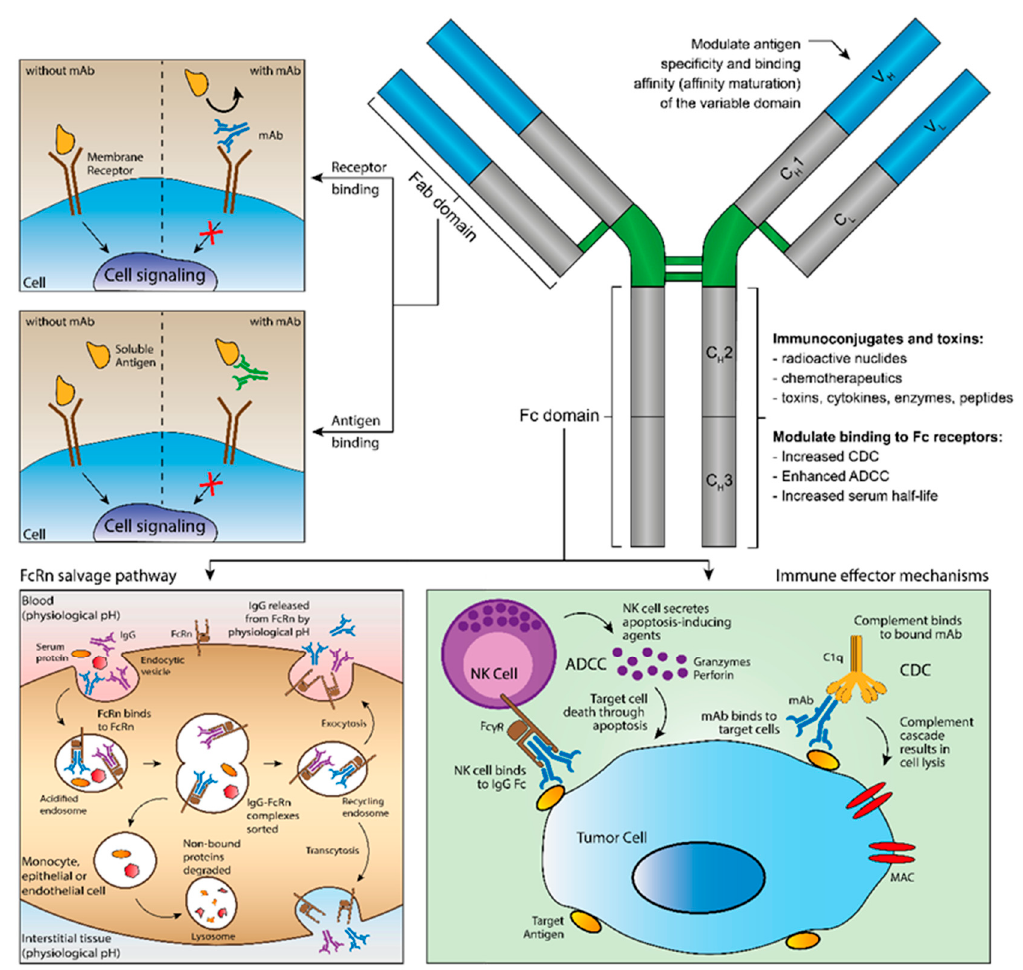
Figure 3. Main functions of therapeutic monoclonal antibodies (mAbs). mAbs have two antigen-binding fragments (Fabs) and one constant fragment crystallizable (Fc). The variable domain of the Fab confers specificity and binding affinity to either membrane receptors or soluble antigens. The Fc domain binds neonatal Fc receptor (FcRn), prolonging the half-life of mAbs; and connects immunoglobulin G (IgG) antibodies to immune effector mechanisms (antibody-dependent cell cytotoxicity—ADCC; and complement-dependent cytotoxicity—CDC) by engaging Fc γ receptors (Fc γ R) on immune cells, promoting cell lysis.